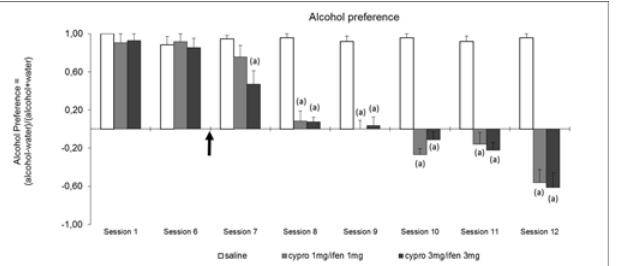
Fig 4. Effect of ifenprodil (ifen) and cyproheptadine (cypro) in combination on alcohol preference during 2 hour sessions with alcohol (10%) and water bottles. The preference index Alcohol/Water (Pref.) is calculated as follows: Pref. = (Alcohol consumption – water consumption) / (Alcohol consumption + water consumption). All groups (Saline, N = 12, cypro 1 + ifen 1, N = 8, cypro 3 + ifen 3, N = 9 received saline treatment at the first two sessions, cyproheptadine and ifenprodil treatments started at the arrow. Results are expressed as mean values ± S.E.M. Statistical analyses: repeated measures ANOVA, group effect F 2;26 = 223.2, p < 0.001, session effect F 6;156 = 45.7, p < 0.001, group × session interaction F 12;156 = 9.5, p < 0.001; one-way ANOVAs, differences between groups in session 1 F 2;21 = 0.7, p = ns; in session 6 F 2;26 = 0.1, p = ns; in sessions 7 – 12, F 2;26 (cid:1) 6.1, p < 0.01; post-hoc comparisons, Dunnett test, (a) significantly different ( p < 0.05) from saline